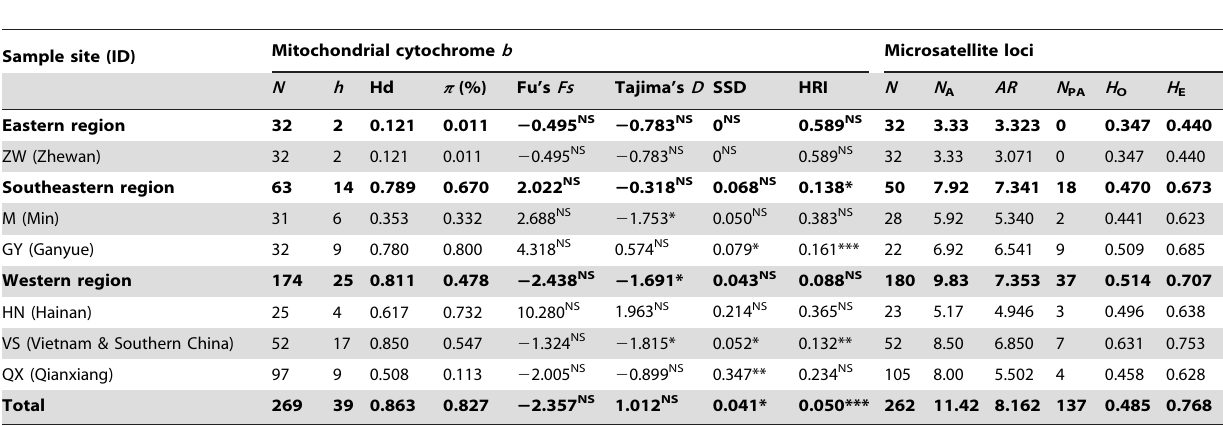
Significant values. *0.05 § P § 0.01,